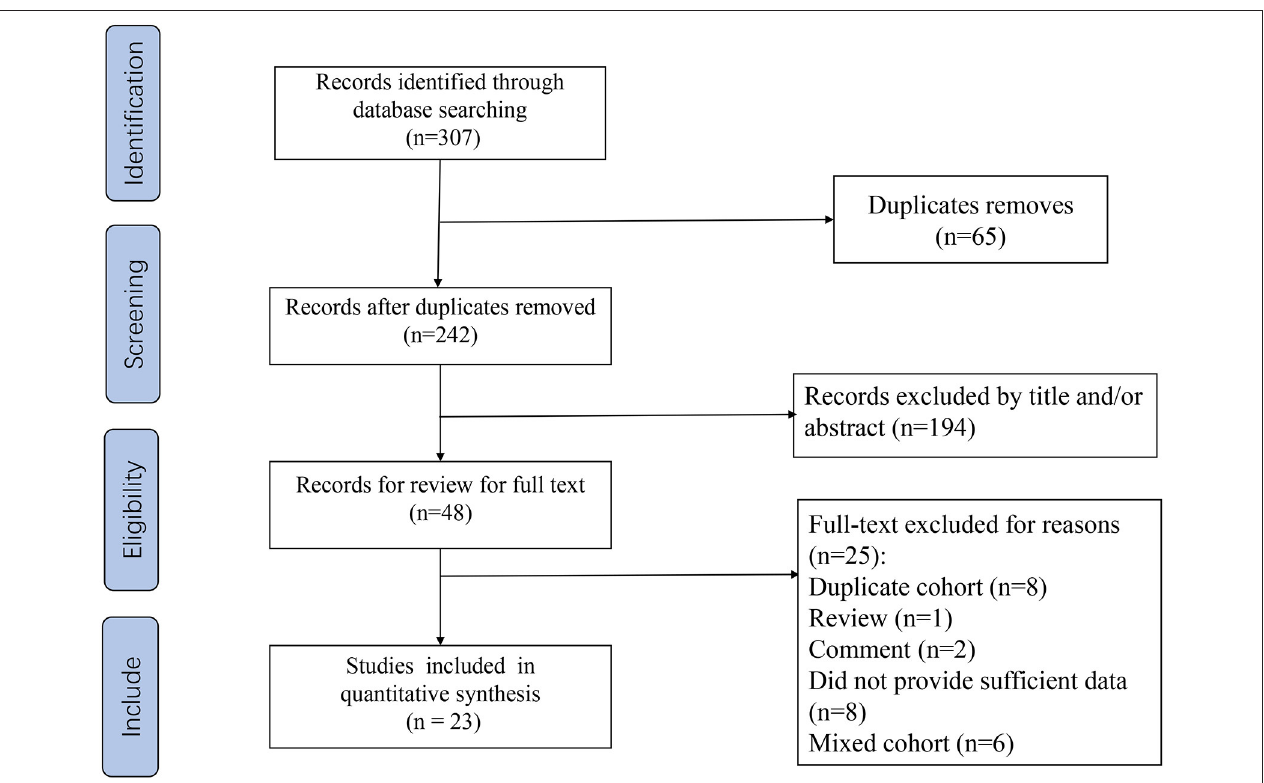
FIGURE 1 | Flow chart of the included